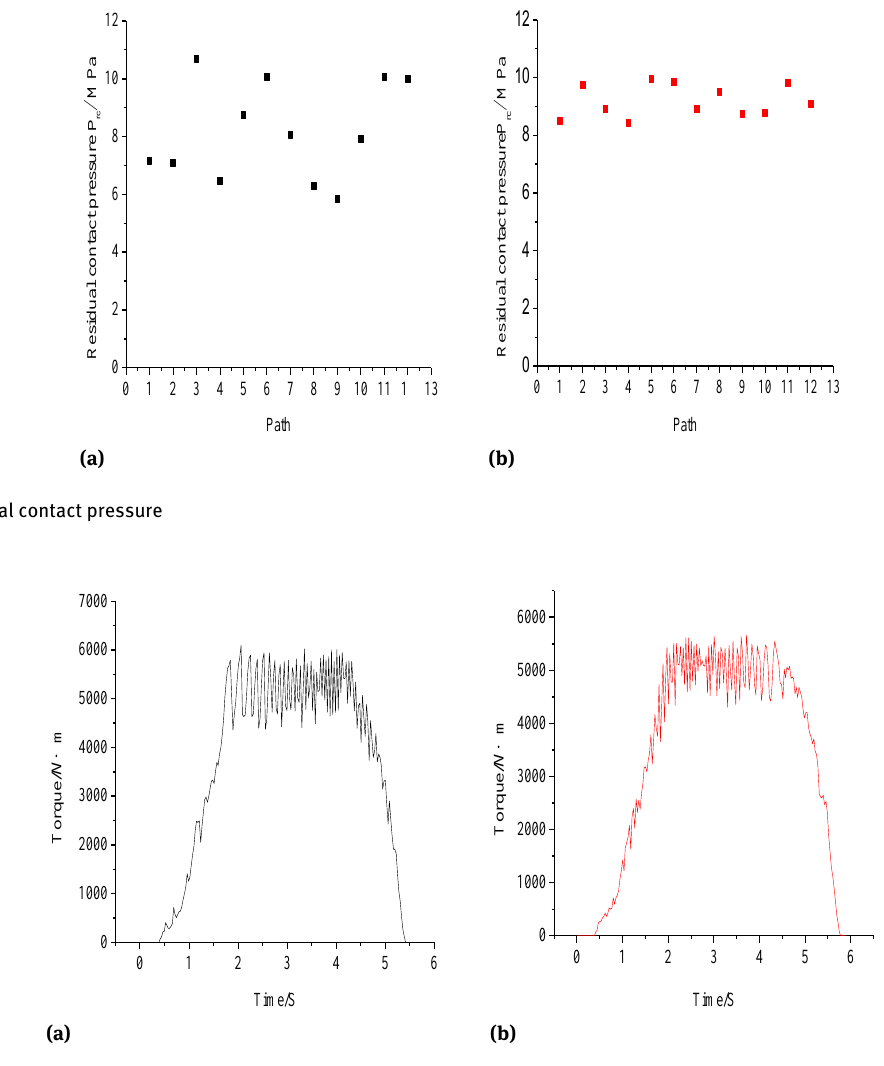
Figure 5: Residual contact pressure